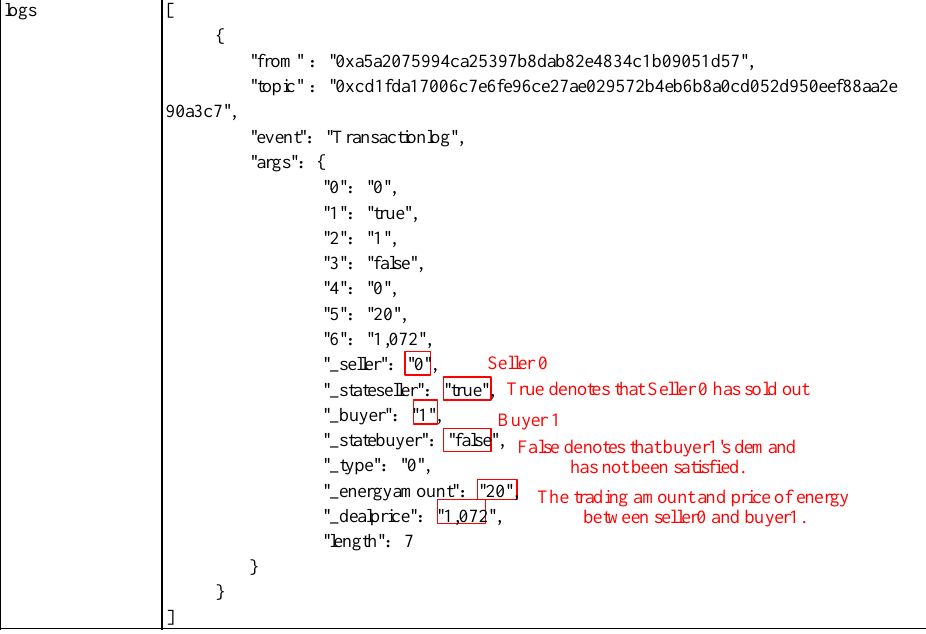
Figure 9. The transaction log in the first matchmaking round.